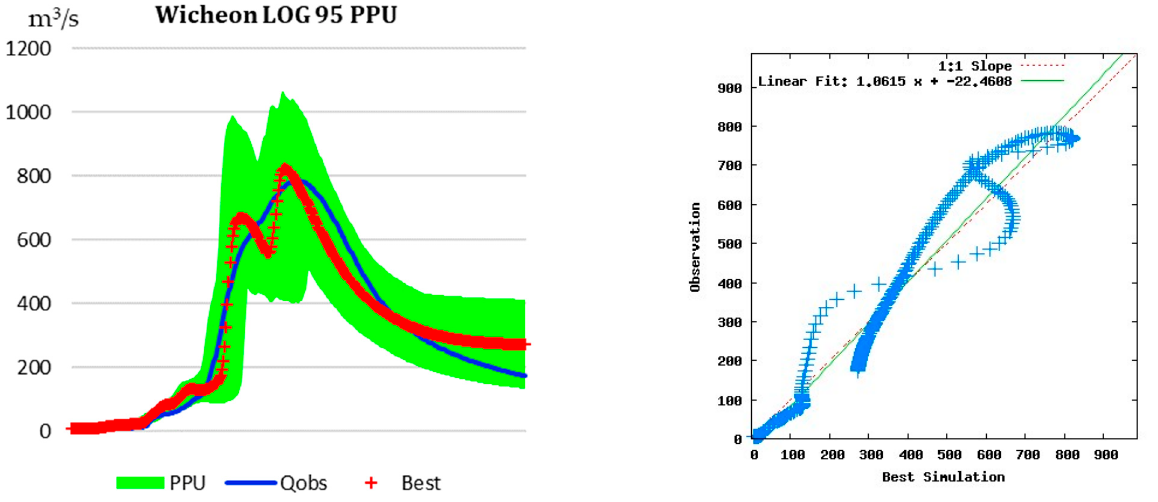
Figure 11. LOG 95 PPU for uncertainty of L 2 -based behavior model.